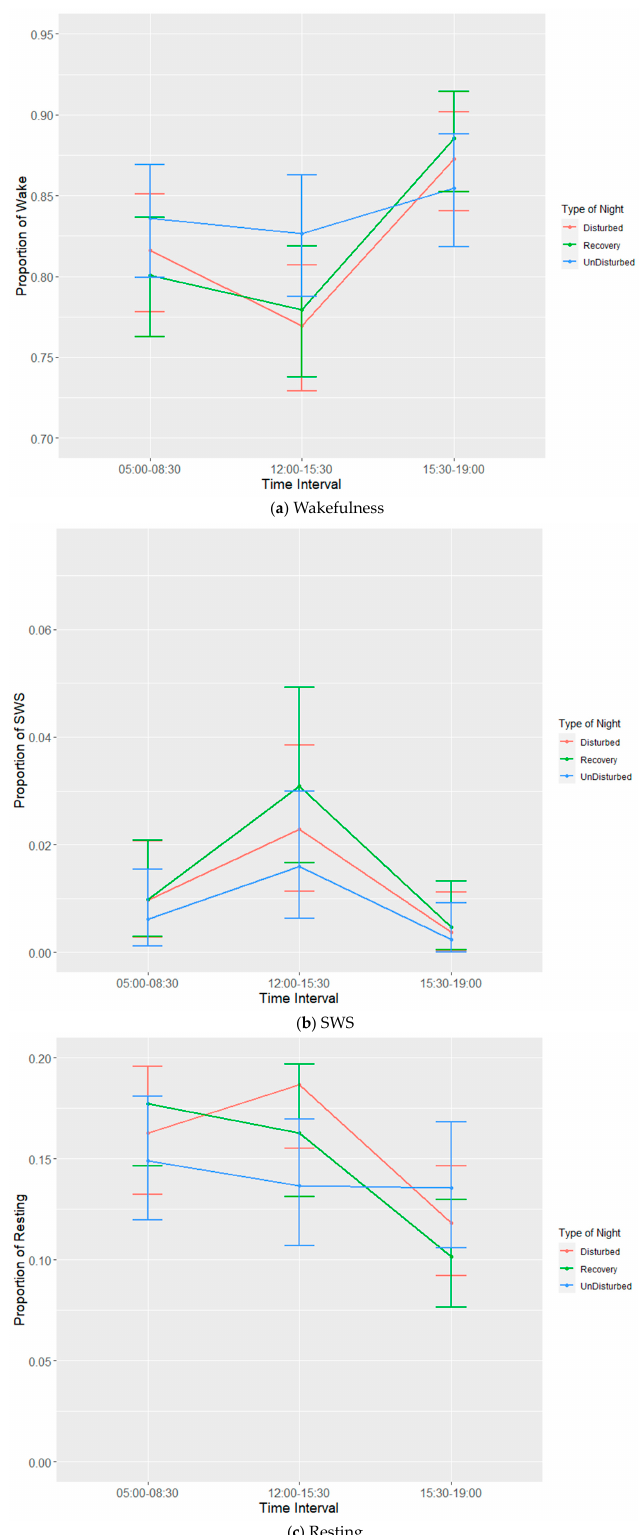
Figure 8. Effects during lights on of the interaction between time interval and three different types of night on proportions of states (( a ) wakefulness (WAKE), ( b ) slow-wave sleep (SWS) and ( c ) rest- ing). Values are back-transformed means ± SEs estimated from LMMs fi tt ed to angular transformed proportions. There was no REM sleep behaviour observed during lights on.